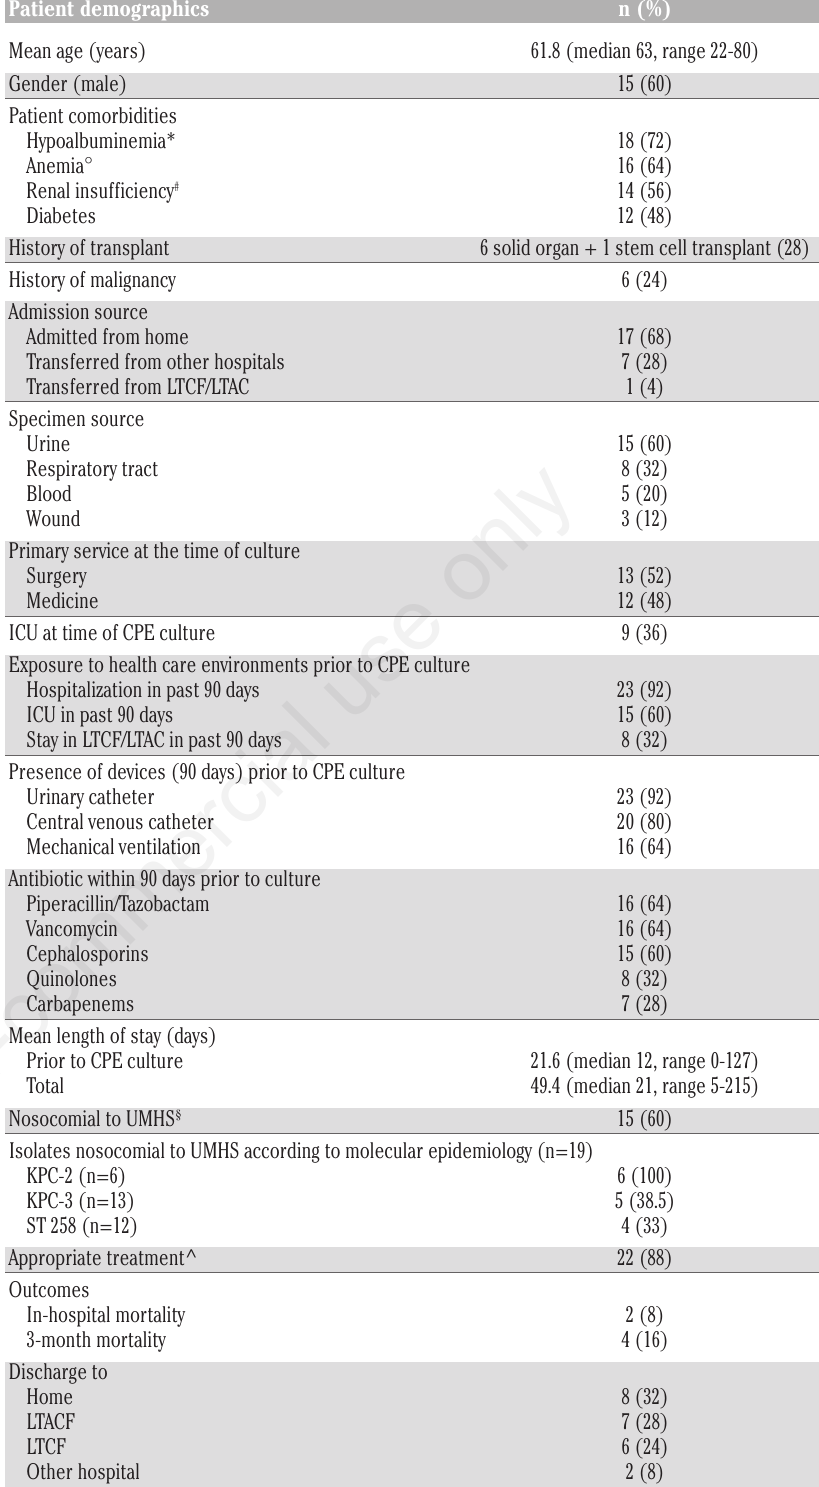
Table 2. Clinical characteristics of patients with carbapenemase producing enterobacte- riaceae